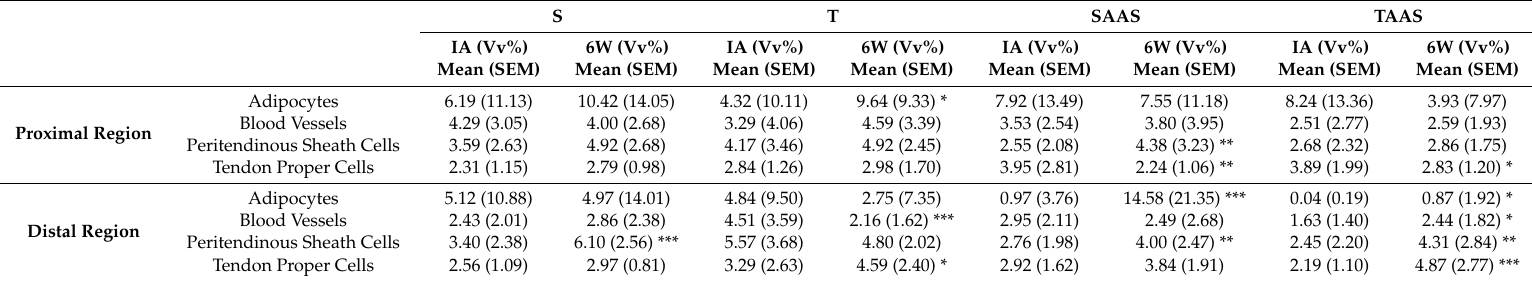
Table 1. Temporal comparison of volume density (Vv%) between IA and 6W